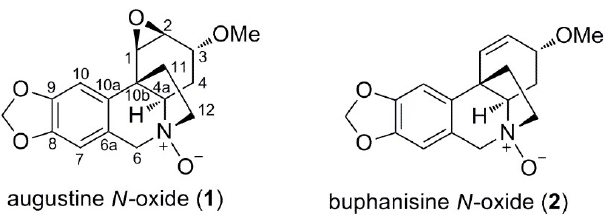
Figure 2. Structures of the two new alkaloids elucidated from C. amabile .